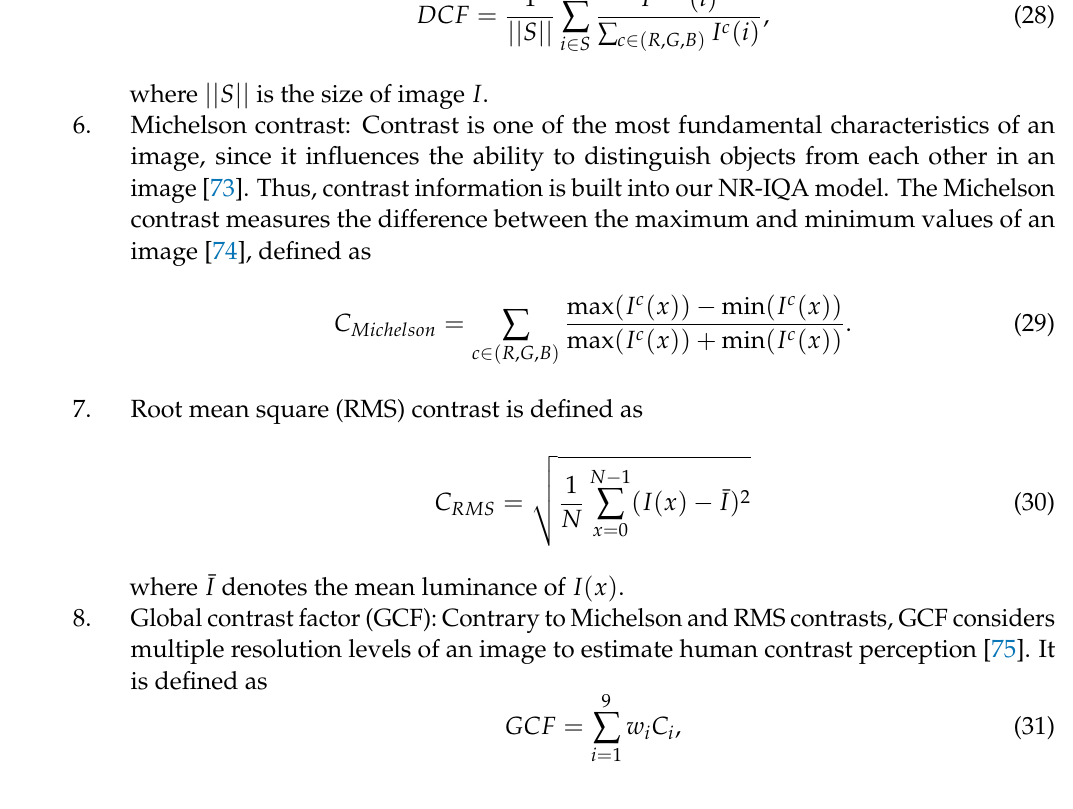
where Ω ( x ) denotes the image patches around the pixel location x . In our implemen- tation, an image patch corresponds to a 15 × 15 square. Next, the DCF is defined as